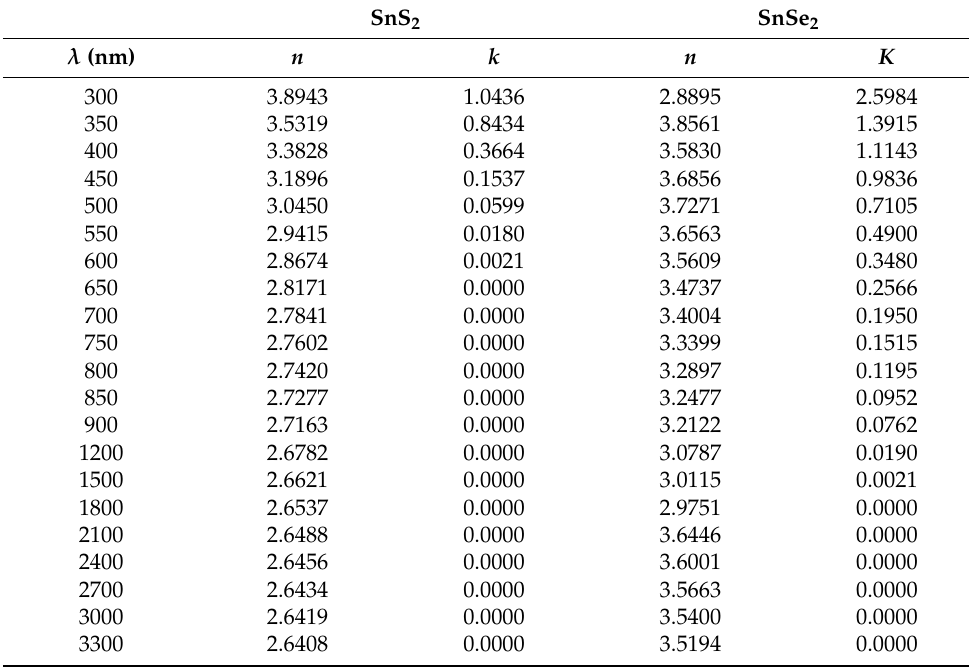
Table A1. Tabulated optical constants for SnS 2 and SnSe 2 films from Figure